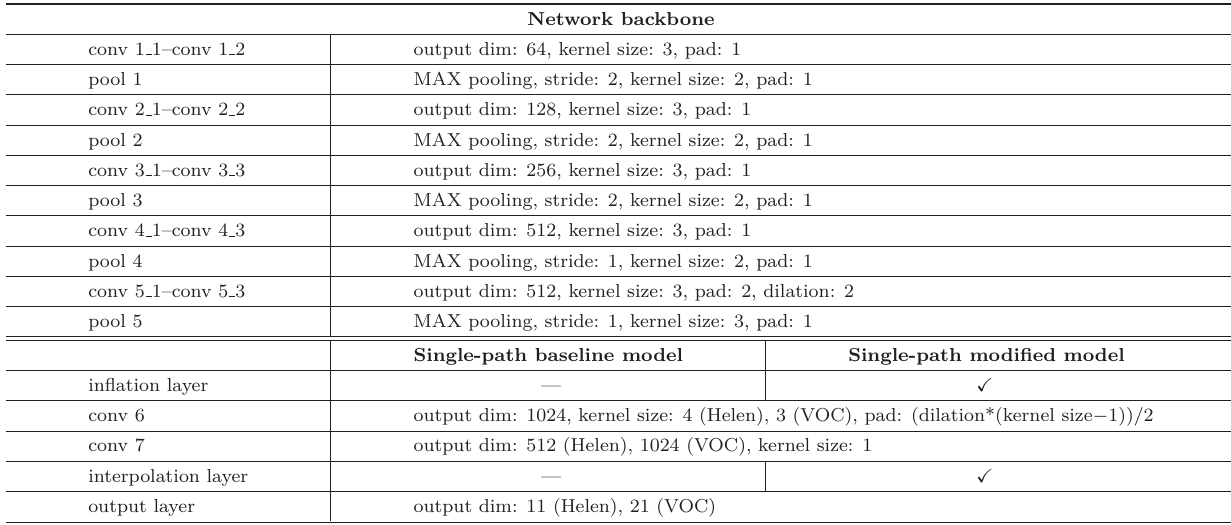
Table 1 Network structures used, including network backbone, single-path baseline model, and single-path modified model Network